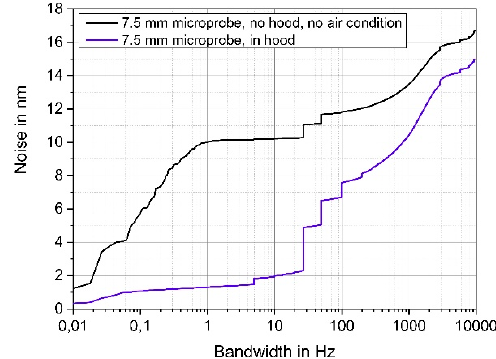
Figure 4. Influence of acoustic shielding hood on the measured noise of a 7.5 mm-long